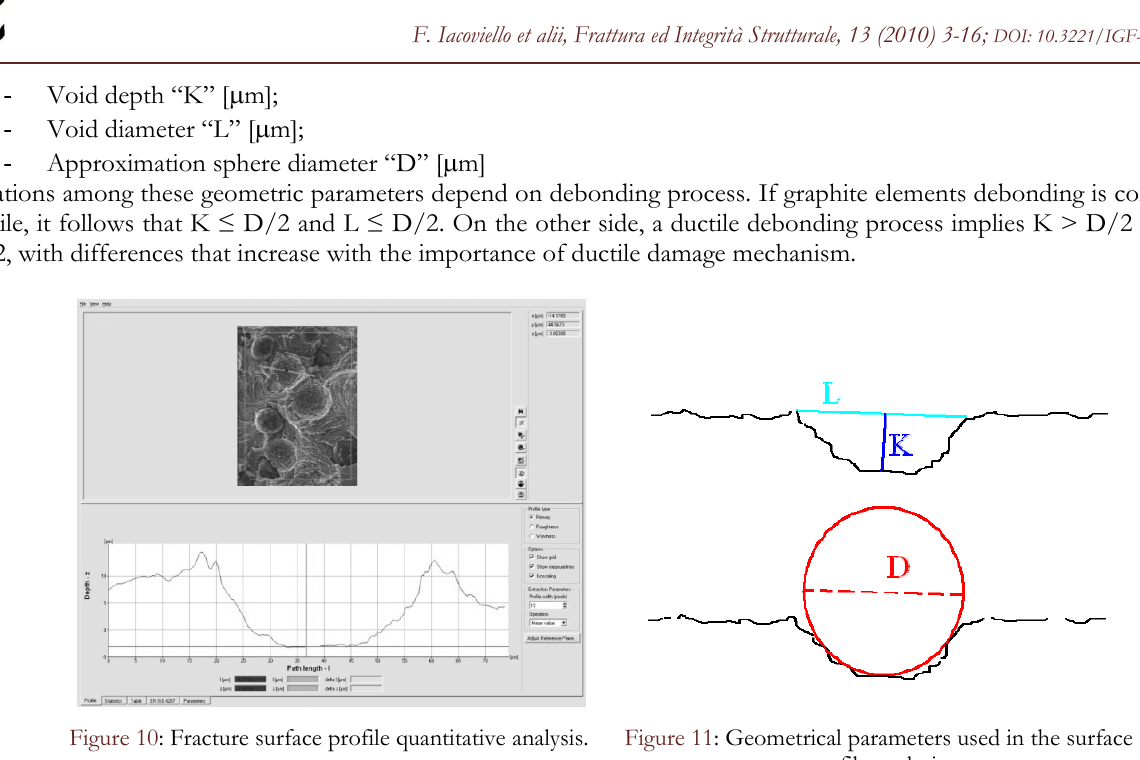
profile analysis.